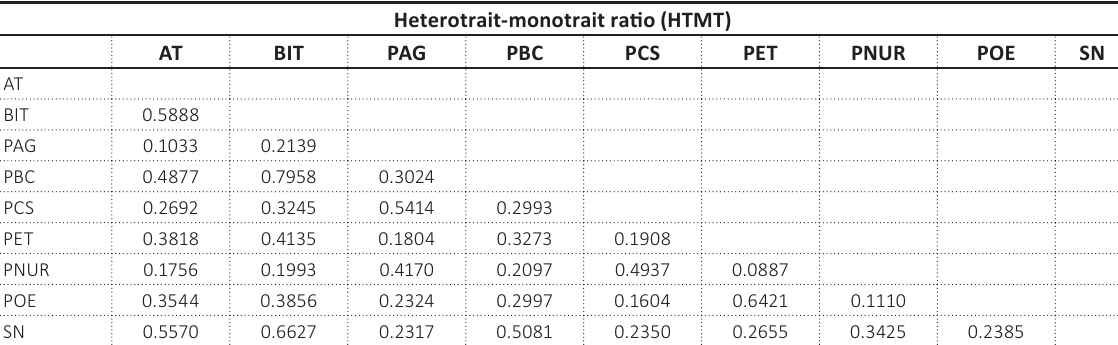
Table 5. Heterotrait-monotrait ratio (HTMT)